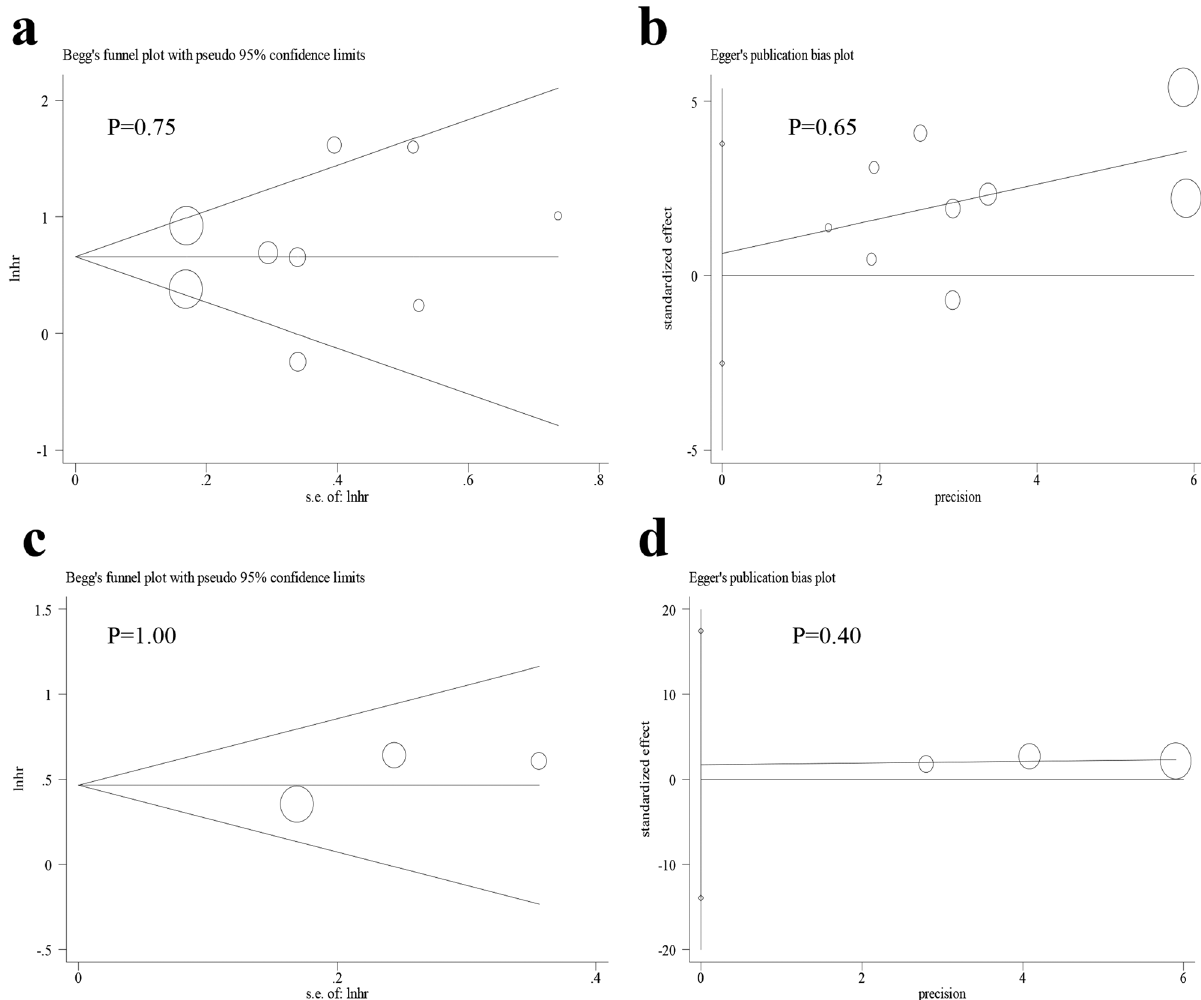
Figure 7: Assessment of publication bias for OS and DFS indicated that there was no obvious publication bias across included studies: ( a ) Begg ’ s test for OS; ( b ) Egger ’ s test for OS; ( c ) Begg ’ s test for DFS; and ( d ) Egger ’ s test for